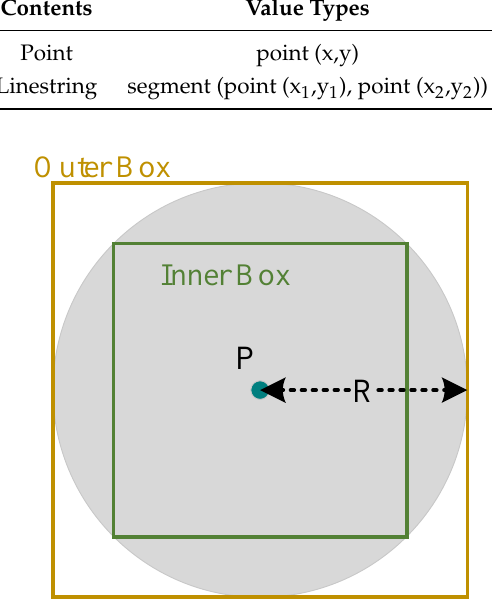
Figure 4. Inner and outer boxes of pixel P with a given radius R